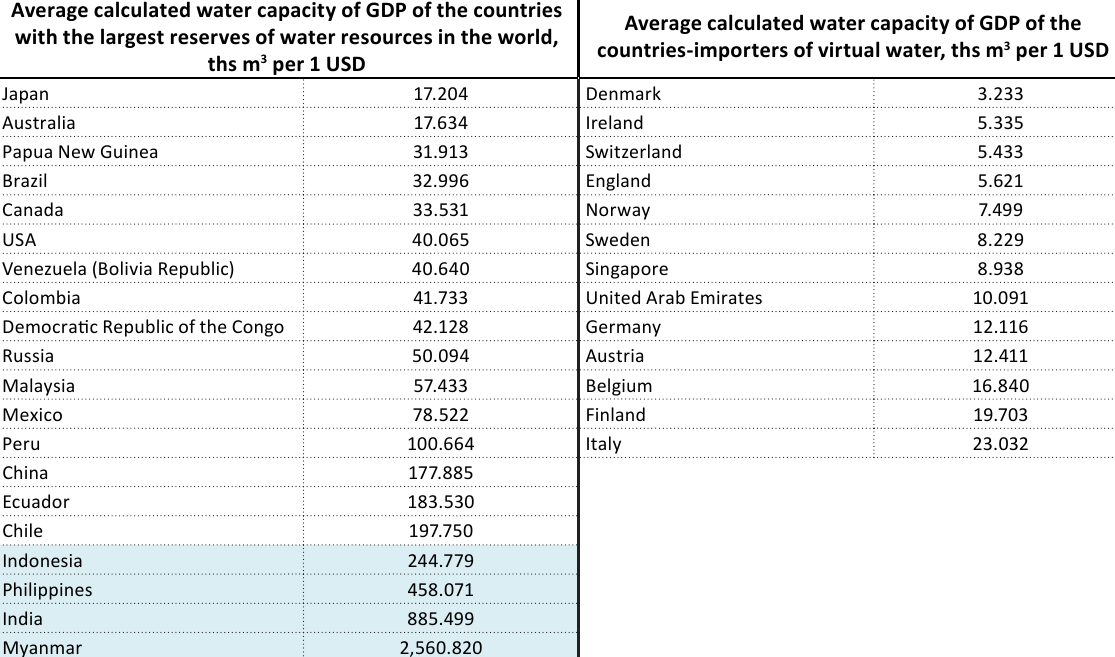
Table 4. Average calculated water capacity of GDP of the countries with the largest water resources in the world and those importing virtual water for the period 1975–2015, ths m 3 per 1 USD Source: Created according to the World Water Council (2016).